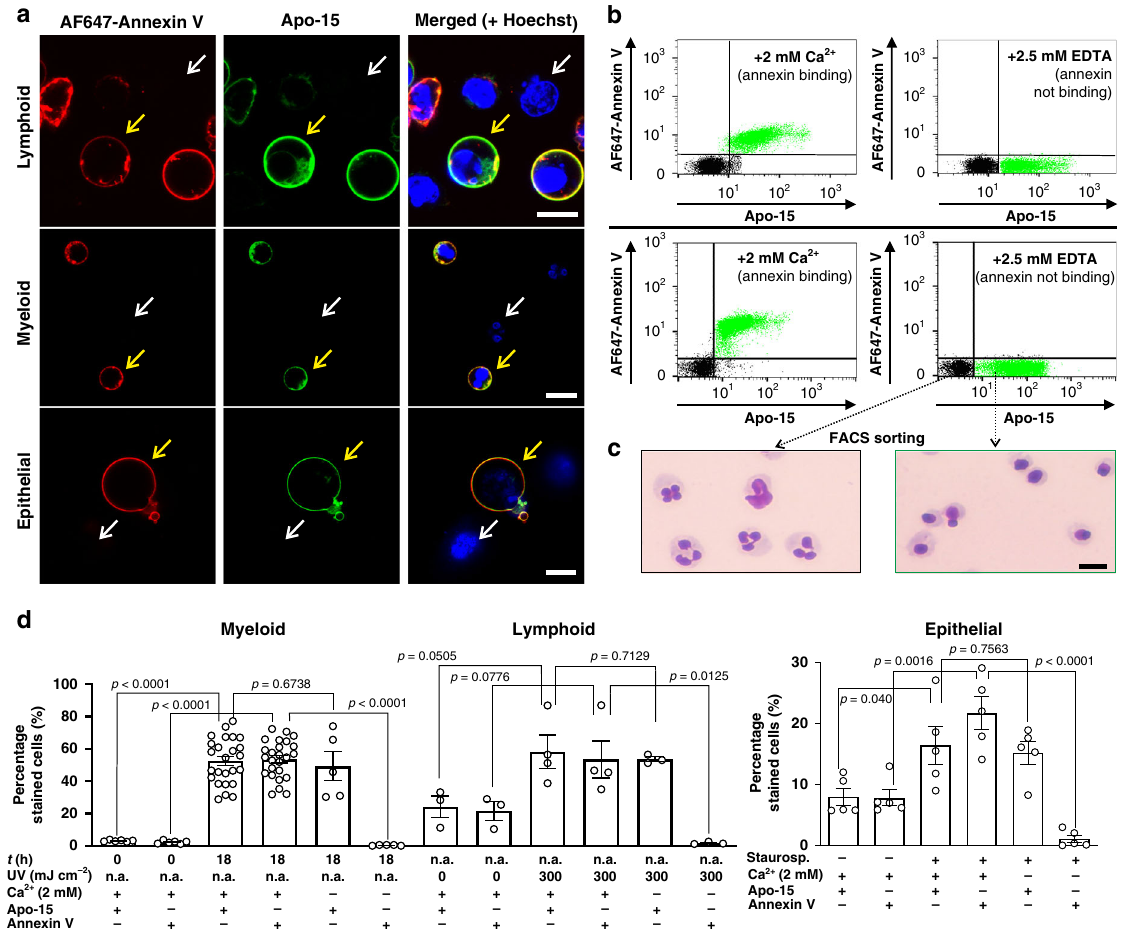
Fig. 2 Apo-15 binds to apoptotic cells of different origin in multiple environments. a Representative fl uorescence confocal microscopy images (from three independent experiments) human apoptotic (yellow arrows) and viable (white arrows) cells from different lineages: BL-2 (lymphoid), neutrophils (myeloid), and primary airway epithelial cells (epithelial). Cells were incubated with Apo-15 (100 nM, green), AF647-Annexin V (5 nM, red), and Hoechst 33342 (7 μ M, blue) for 10 min and imaged under a fl uorescence confocal microscope ( λ exc. : 405, 488, 633 nm: λ em. : 450, 525, 670 nm). Scale bars: 10 µ m. b Divalent cation-independent binding of Apo-15 to apoptotic cells of different origin (top plots: lymphoid cells, bottom plots: myeloid cells). Mixtures of apoptotic (highlighted in green dots) and viable cells (highlighted in black dots) were stained with AF647-Annexin V (25 nM) and Apo-15 (100 nM) in the presence of 2 mM CaCl 2 (left) or 2.5 mM EDTA (right). Representative histograms showing Apo-15 binding ( x -axis) vs AF647-Annexin V binding ( y -axis) acquired on 5L LSR fl ow cytometer ( n = 5). c Cells were sorted on their Apo-15 positivity (green populations in panel b ) or negativity (black populations in panel b ). Gating strategy in Supplementary Fig. 7. Morphological analysis (four independent images from two independent experiments) of cytocentrifuge preparations of Apo-15 -positive and Apo-15 -negative cells under bright fi eld microscopy (scale bar: 10 µ m). d Quanti fi cation of fl uorescence staining of neutrophils (myeloid, n ≥ 5), BL-2 cells (lymphoid, n ≥ 3) and primary airway epithelial cells (epithelial, n = 5) before and after induction of apoptosis and upon treatment with Apo-15 and AF647-Annexin V. Data acquired on 5 L LSR fl ow cytometer and presented as mean values ± SEM. P values obtained from two-tailed t tests. Source data (in d ) are provided as a Source data fi